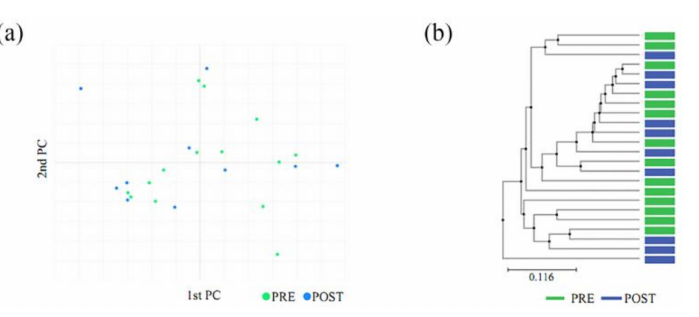
Figure 5. Beta diversity index for the salivary microbiome of cancer patients. ( a ) UniFrac-based PCoA (principal coordinate analysis) and ( b ) UPGMA (unweighted pair group method with arithmetic mean) were applied to the beta diversity analysis of the salivary microbiome.